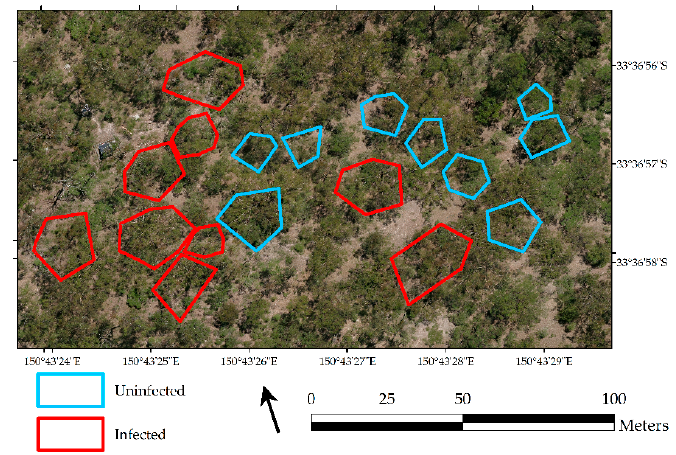
Figure 2. Map overview of the infected and uninfected trees selected in the study. The background is the RGB orthophoto made on 30/01/2015.